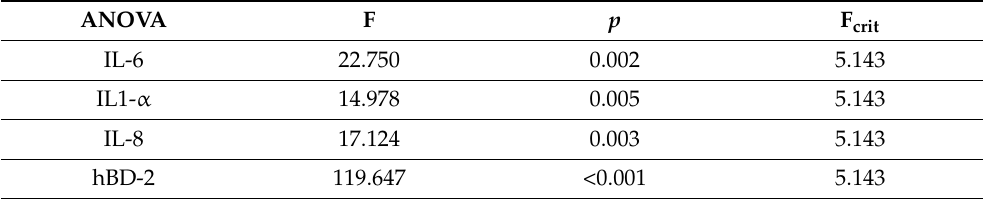
Table 7. Single-factor ANOVA test. With reference to the figures above, the divergent trends of the HaCaT controls, the cultures infected with M. furfur, and the cultures also exposed to uwf-EMF yield significant differences at a significance level of p < α (0.05). Accordingly, H 0 was rejected for IL-6, IL-1 α , IL-8, and hBD-2, as confirmed by the corresponding F-values, which are much greater than those of F crit